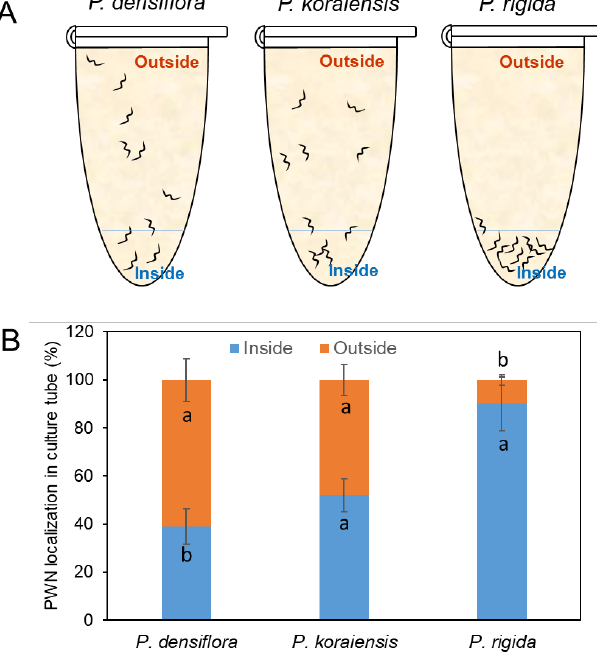
Figure 2. Movement of PWNs inside and outside of resin from three Pinus species ( P. densiflora , P. koraiensis, and P. rigida ) during 3 days of culture. ( A ) Location of PWNs in resin or outside of resin in a PCR tube. ( B ) Number of PWNs located in resin (inside ) or outside of resin after 3 days. Experiment was repeated in triplicate. Error bars indicate the standard error of the mean ( ± SE) of three replicate measurements. Different letters above the bars indicate significantly different values ( p < 0.05), calculated using one-way ANOVA followed by Duncan’s post hoc analysis.